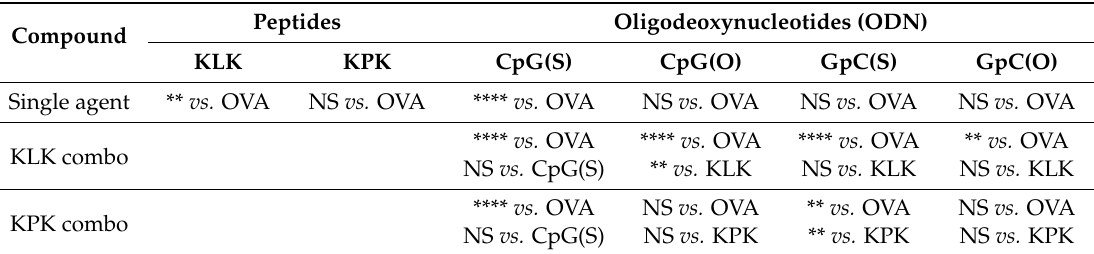
Table 2. Summary of adjuvant effects on anti-OVA antibody titers.